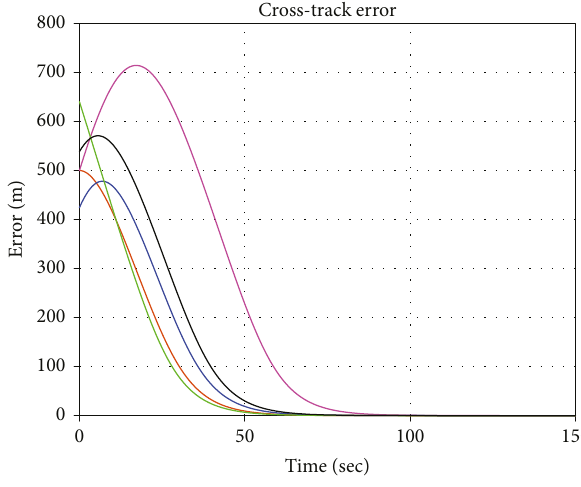
Cross-track error